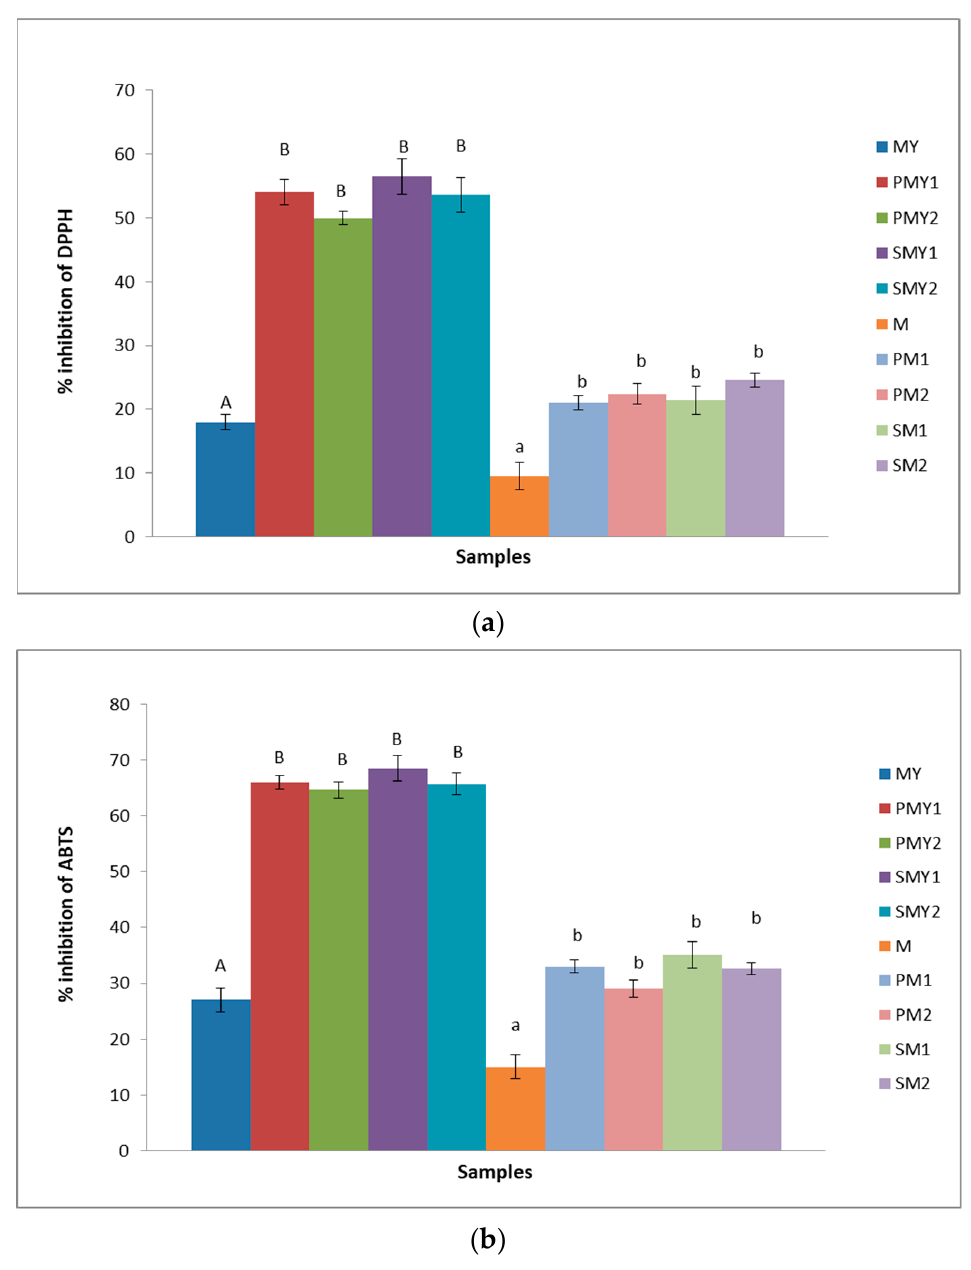
Figure 2. ( a ) Antioxidant characteristics of investigated samples. DPPH Method; ( b ) Antioxidant characteristics of investigated samples. ABTS Method. Explanatory notes: The presented samples are coded according to Section 2; Table 1. Values denoted by different upper-case letters in the cultivar “ Melon Yellow ” of the Cucurbita maxima species raw material, pumpkin fermented pulp and frozen desserts, differ significantly ( p < 0.05). Values denoted by different lower-case letters in the “ Miranda ” of the Cucurbita moschata species raw material, pumpkin fermented pulp and frozen desserts, differ significantly ( p < 0.05). The results are expressed as the mean ± standard deviation ( n =